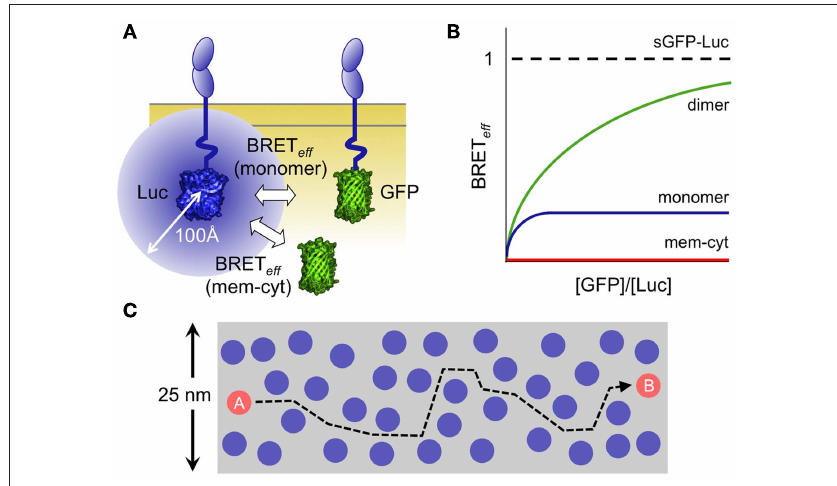
Figure 1 | Analysis of protein interactions using bioluminescence resonance energy transfer (BreT). (A) Schematic showing a monomeric protein expressed at the cell surface as chimeras with luciferase (Luc) and a green fluorescent protein (GFP) acting as donors and acceptors, respectively. The blue circle represents the 100 Å sphere within which random or stable co-association of Luc and GFP allows energy transfer. (B) Graphical representation of the relationship of energy transfer efficiency (BRET ) to the acceptor/donor ratio for dimeric (green) and monomeric (blue) protein pairs expressed at the eff membrane, versus that measured for a pair of proteins one of which is expressed at the membrane (mem) and the other in the cytoplasm (cyt; James et al., 2006, 2011). In practice, the transfer efficiency is normalized against that measured for a soluble GFP/Luc fusion protein (sGFP–Luc) expressed in the cytoplasm. (C) The efficiency of energy transfer arising via random interactions is explained by the high density of membrane surface proteins and by their high mobility. Protein density is illustrated to scale, assuming that there are 20,000 molecules/μm 2 , and that each protein is 4 nm in diameter (Grasberger et al., 1986). It takes 0.2–0.3 s for a protein to move from position A to position B, based on measurements of the TCR diffusion rate (James et al., 2007). Since many of the proteins are likely diffusing at comparable rates, numerous random interactions seem unavoidable. Some estimates for the expression levels of cell surface proteins are substantially higher (Quinn et al.,